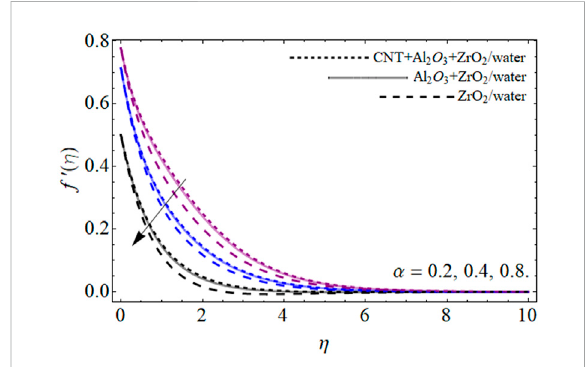
FIGURE 2 Velocity outlines f ′ ( η ) versus velocity slip factor α .